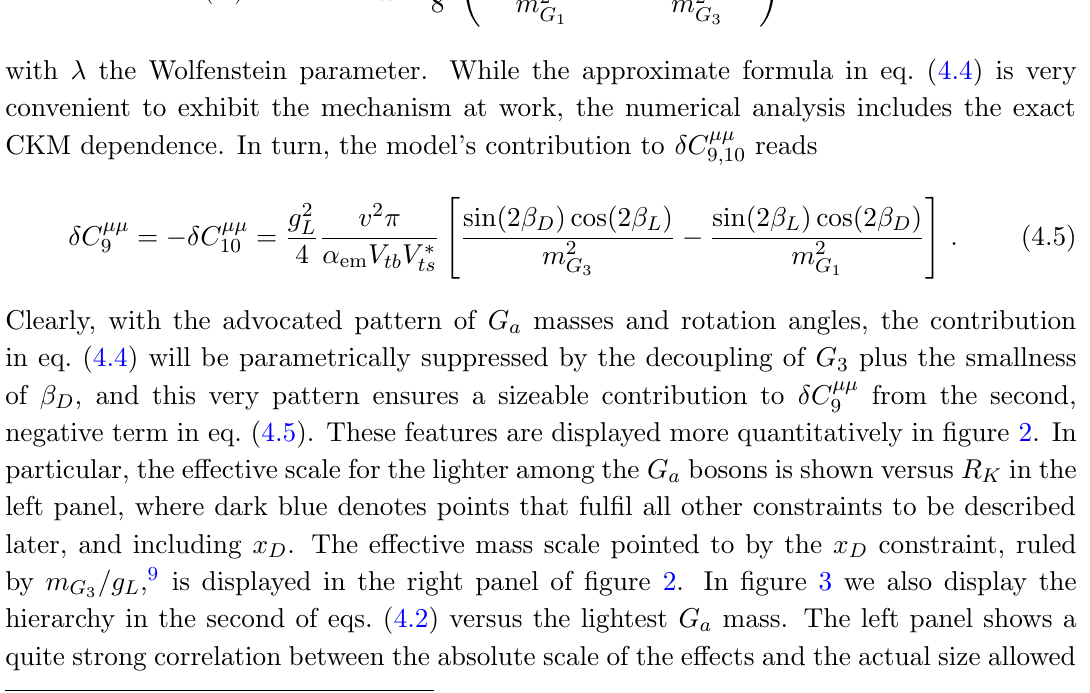
Figure 2 . Color code henceforth: grey points ful(cid:12)l all constraints except R K and x D ; light-blue points also ful(cid:12)l R K , but not x D ; dark-blue points ful(cid:12)l all constraints. Left panel: R K vs. m G as implied by eq. (4.5). Right panel: e(cid:11)ective mass scale for the heavier among the G a bosons, as required by the x D constraint. The horizontal dashed line denotes the 3 (cid:27) upper bound on x D